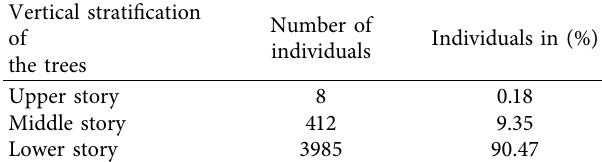
Table 5: Over story classifcation of the forest. Vertical